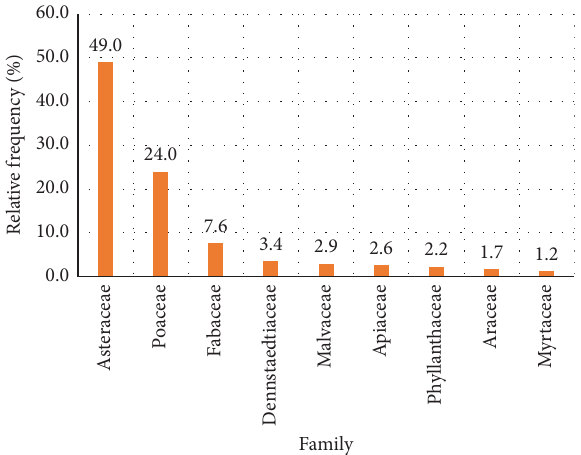
Figure 6: Diversity of families most represented in the